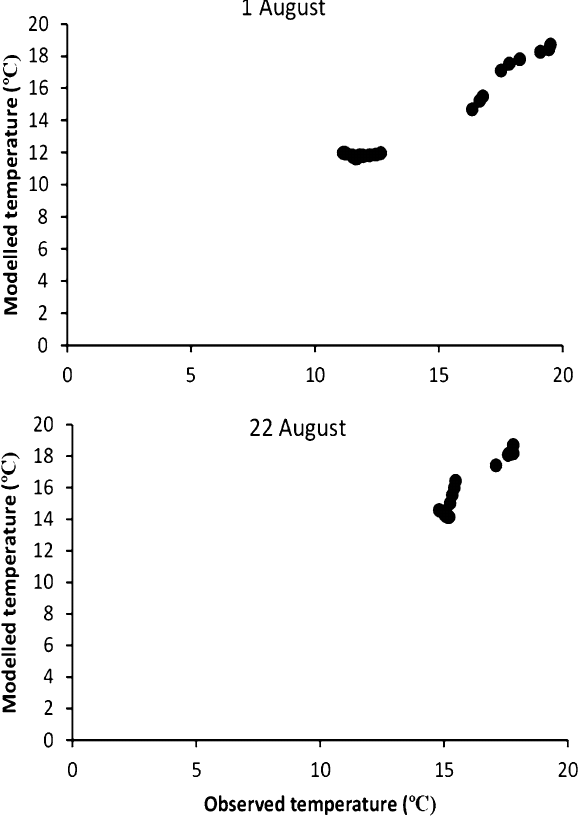
Fig. 5 Observed vs modelled temperatures on 1 August ( top ) and 22 August ( bottom )